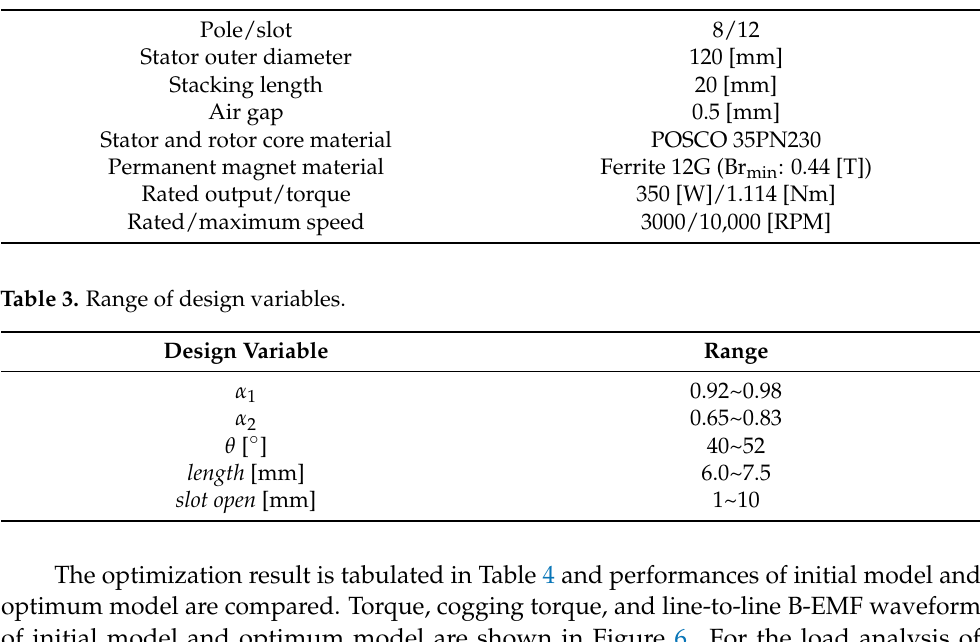
Figure 5. Configuration of the target PMa-SynRM and design variables. Table 3. Range of design variables. Table 2. Specifications and requirements of the target motor.